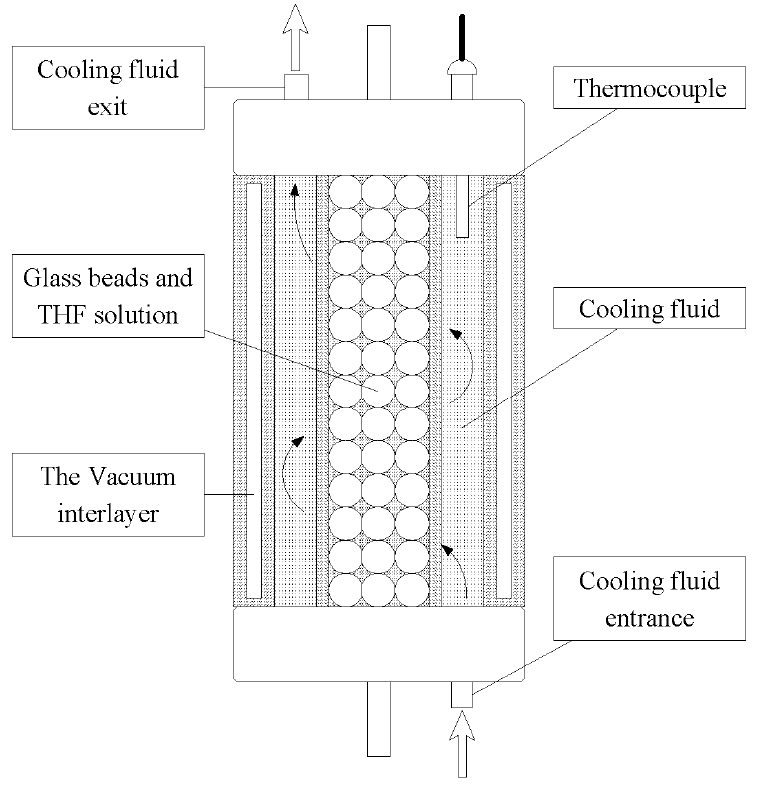
Figure 2. Schematic diagram of the MRI